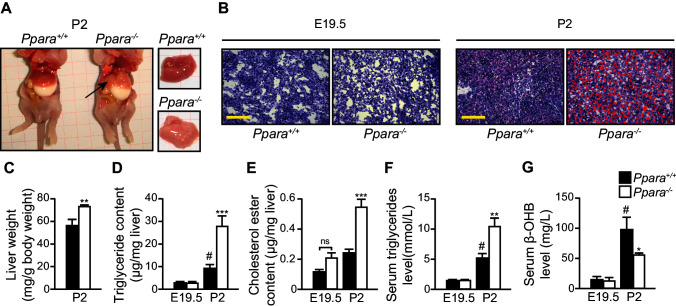
PPARα deficiency leads to congenital hepatic steatosis after birth.(A) Photographs showing dissected Ppara-/- and Ppara+/+ pups (left) and livers (right). The pallid liver of a Ppara-/- pup is indicated by an arrow. The white content of the stomach indicates milk ingestion. (B) Representative Oil Red O-stained liver sections counterstained with methylene blue. Scale bars = 100 μm. (C–G) The Mean body weight (C), triglyceride (D) and cholesterol ester (E) contents of the liver, and serum levels of triglyceride (F) and β-hydroxybutyrate (β-OHB) (G). Data are presented as mean ± SEM; n = 6, *p<0.05, **p<0.01, ***p<0.001 vs. wild-type controls; #p<0.05 vs. respective E19.5; ns, not significant (two-way ANOVA with Bonferroni post-hoc analysis).